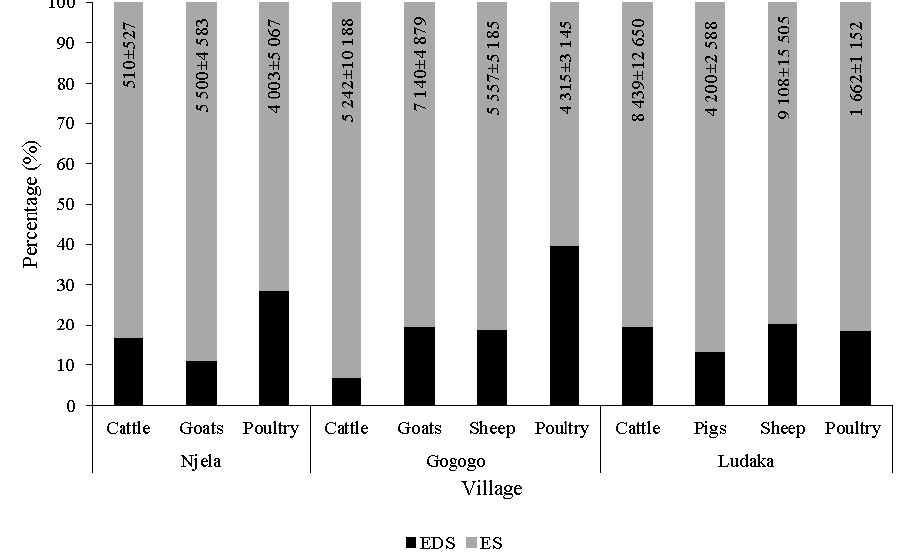
Figure 2. Ecosystem services (ES) and EDS reflected as a percentage of the average potential household value of livestock consumptive outputs amongst owner households, economic values at the top of the graph represent total potential values if not for